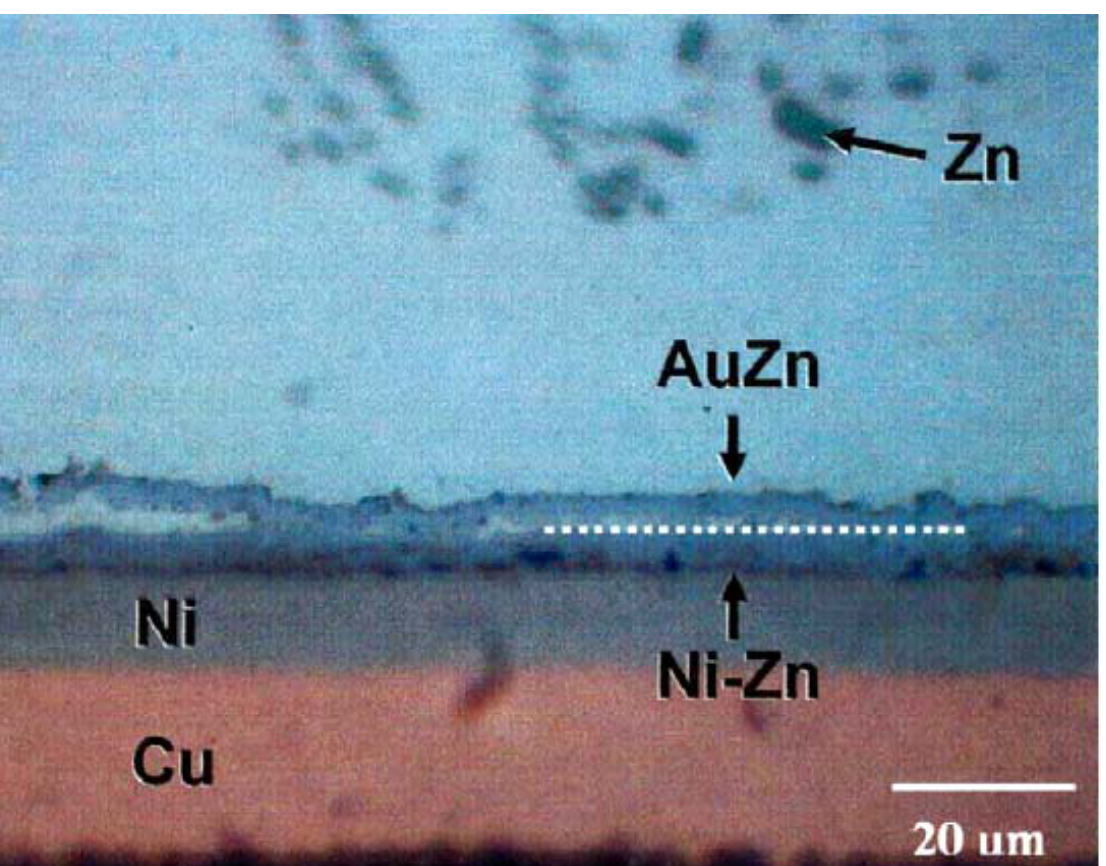
Figure 25. Interfacial microstructure after reflow and 900 hours annealing at 150 ° between Sn-7at-%Zn solder and Au/Ni/Cu pad